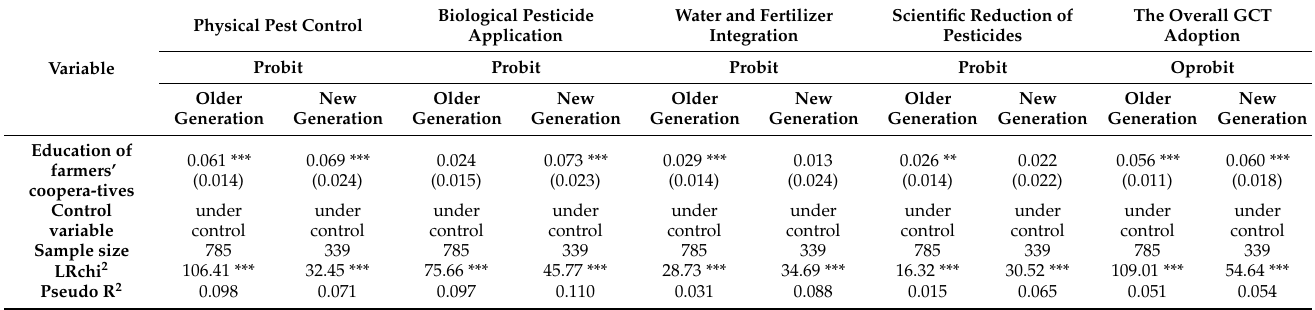
Table 10. Effects of cooperative’s education on GCT adoption of members from different